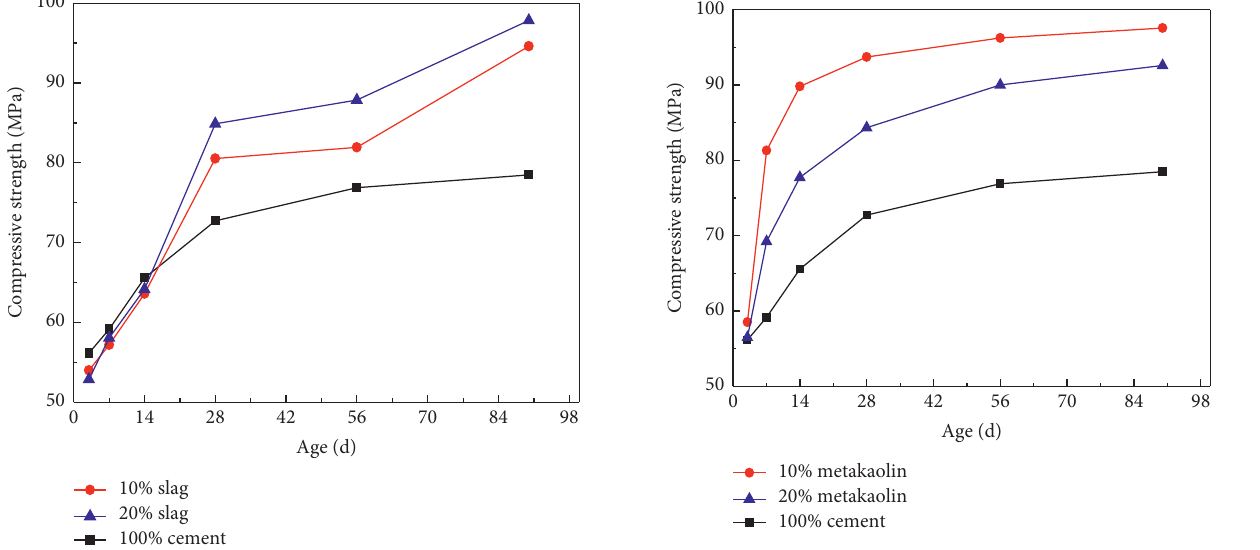
Figure 11: Effect of PCE-2 and slag dosage on the compressive strength of cement mortar.